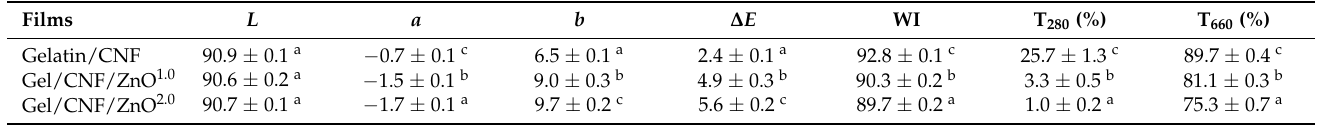
Table 1. Surface color and transmittance of the gelatin/CNF ‐ based films.